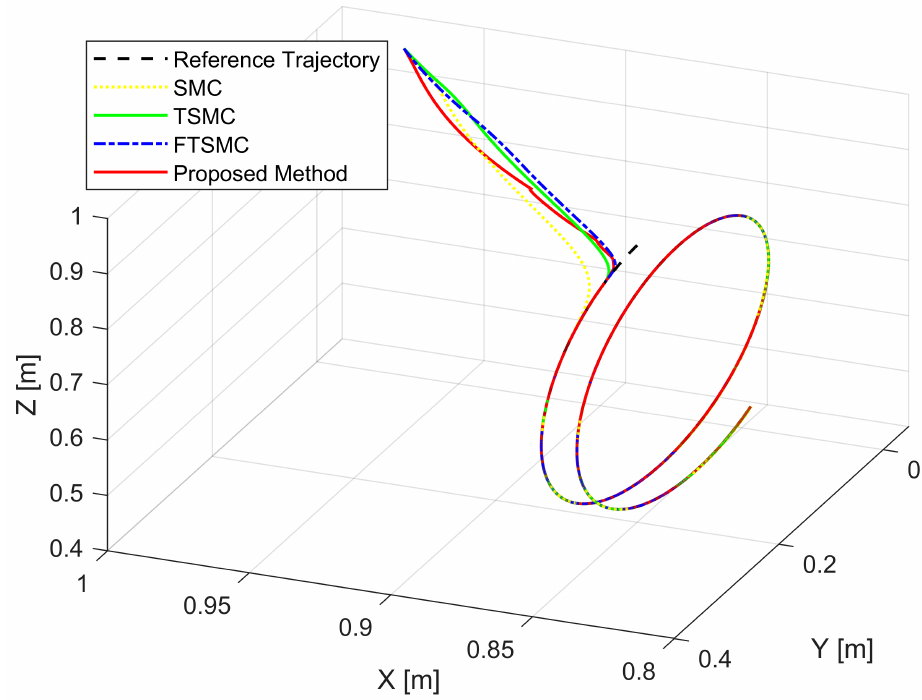
Figure 7. The real trajectories under all controllers versus the desired